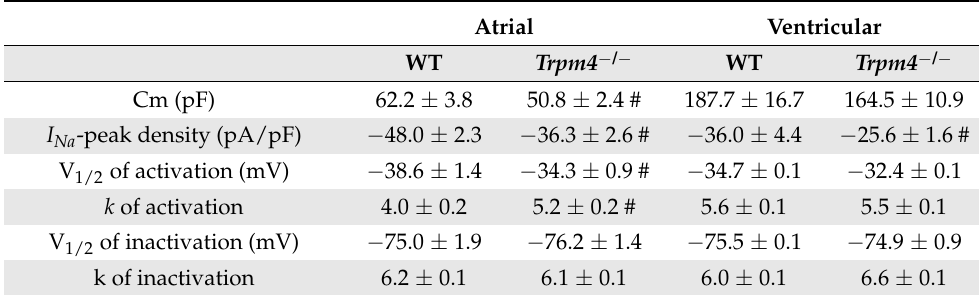
Table 2. Summary of I Na patch clamp data. (#: p ≤ 0.05, WT vs. Trpm4 −/− ).